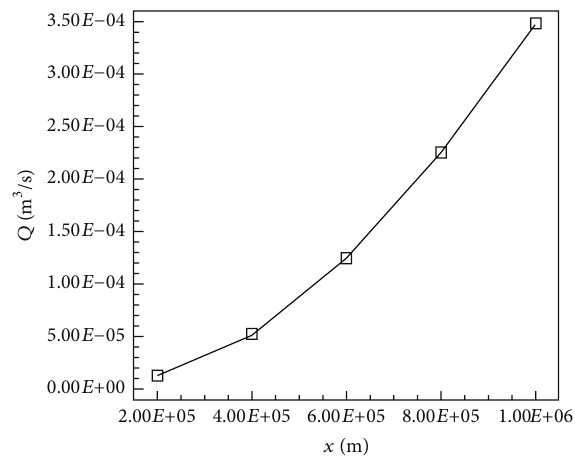
Figure 7: The flux at the outlet of the microchannel under different applied electric